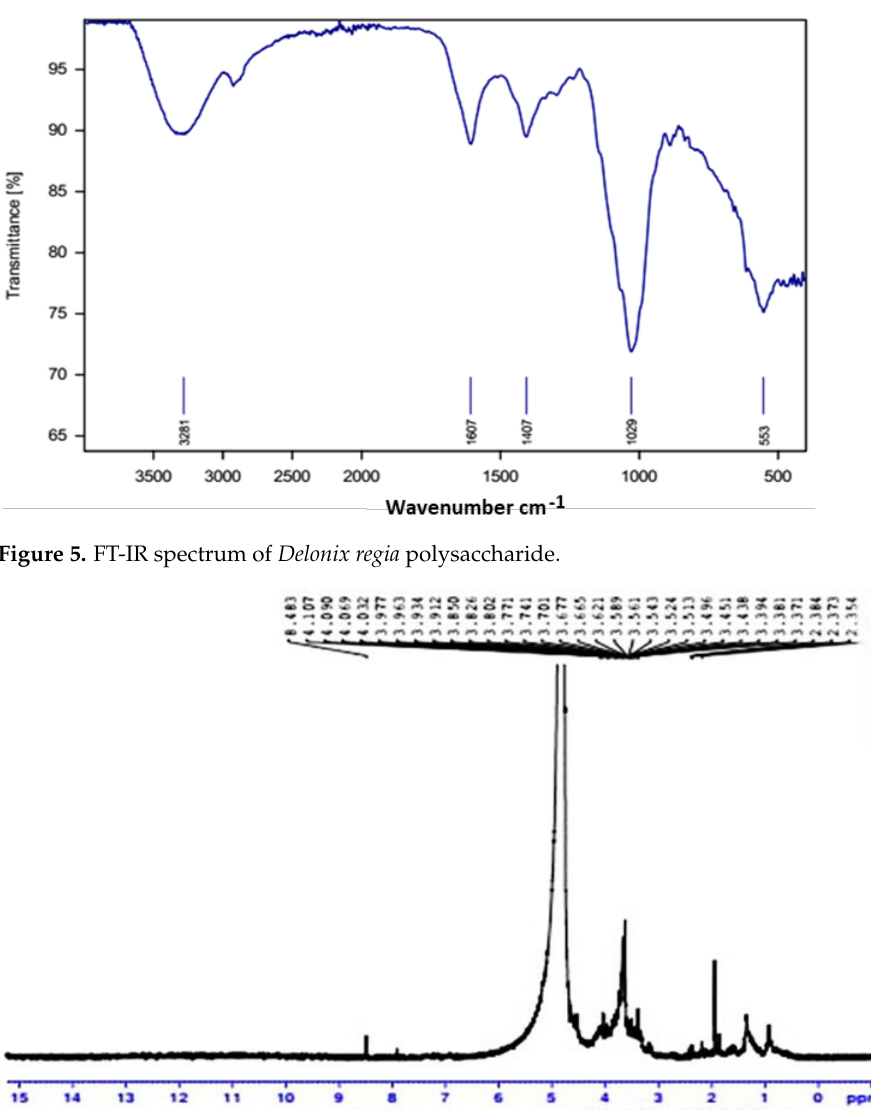
Table 2. Monosaccharide profile of isolated DR polysaccharides detected by